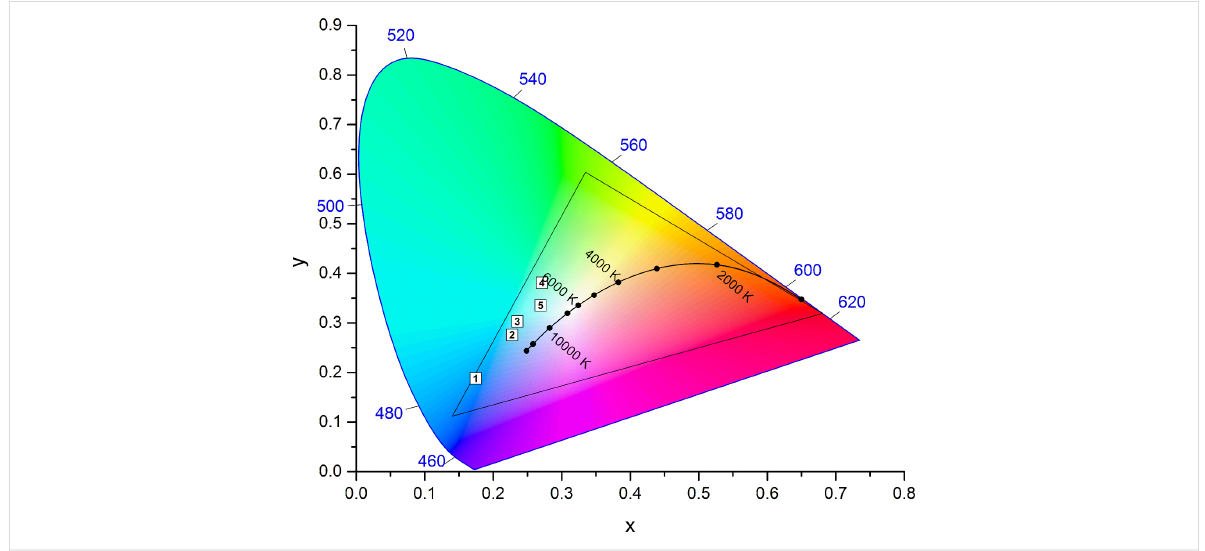
Figure 5: CIE 1931 color space chromaticity diagram (2° observer) with the color space accessible by mixing these three precursors 9 (blue), 10 (green), and 8 (red) in ethanol shown as triangle as well as the CIE coordinates of the hybrid blends